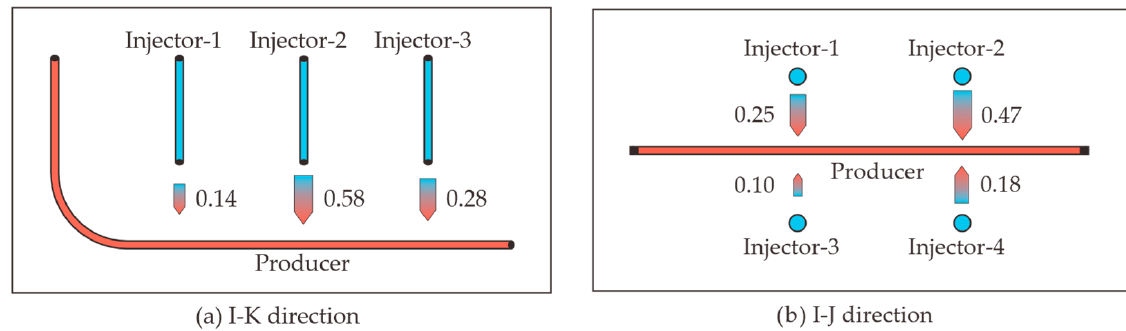
Figure 9. SAGD inter-well connectivity inferring results: ( a ) linear pa tt ern; ( b ) fi ve-spot pa tt ern.